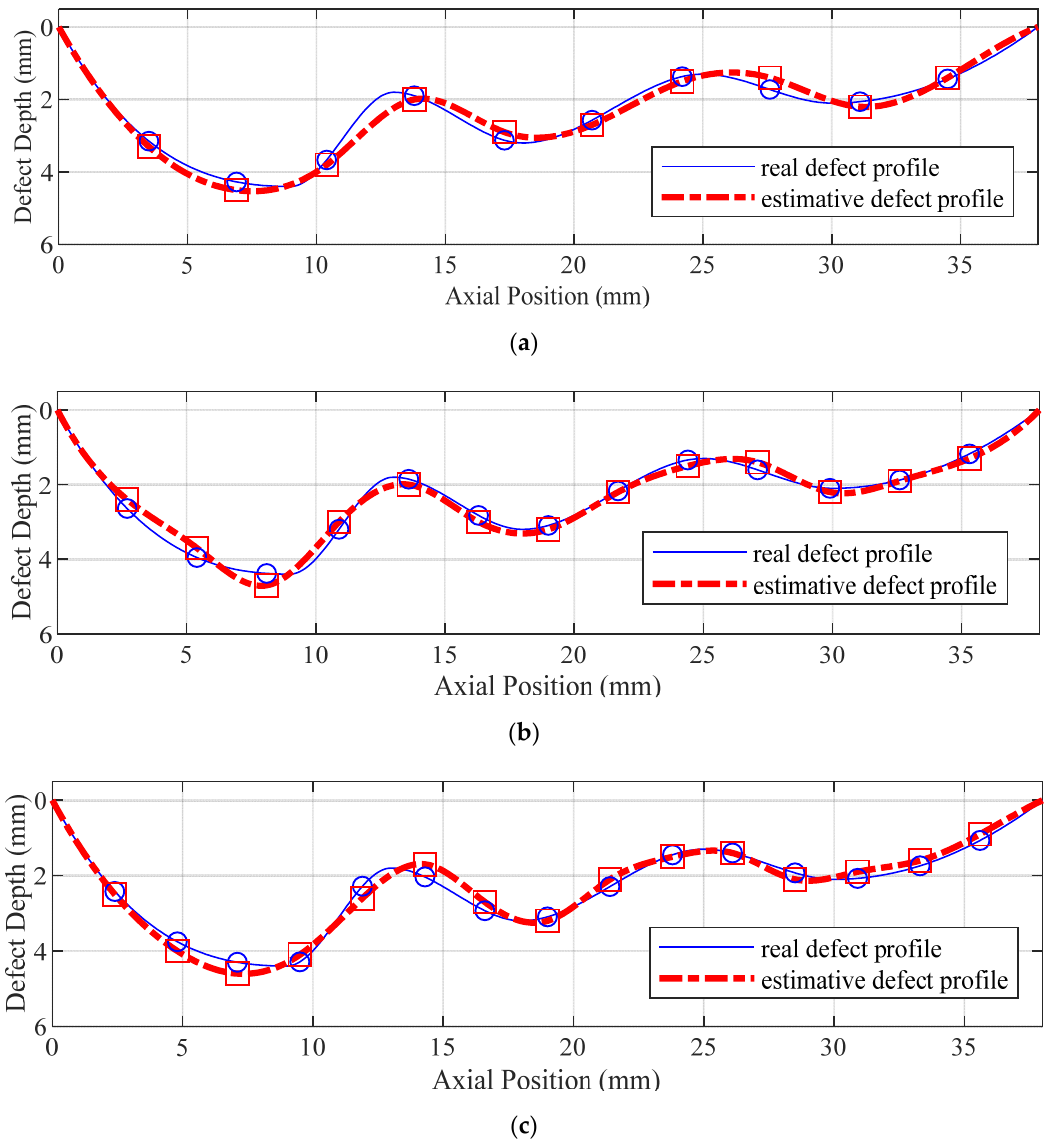
Figure 9. The real defect profile and the calculated inversion profile with different DOFs. ( a ) DOFs of 10; ( b ) DOFs of 13; ( c ) DOFs of 15.